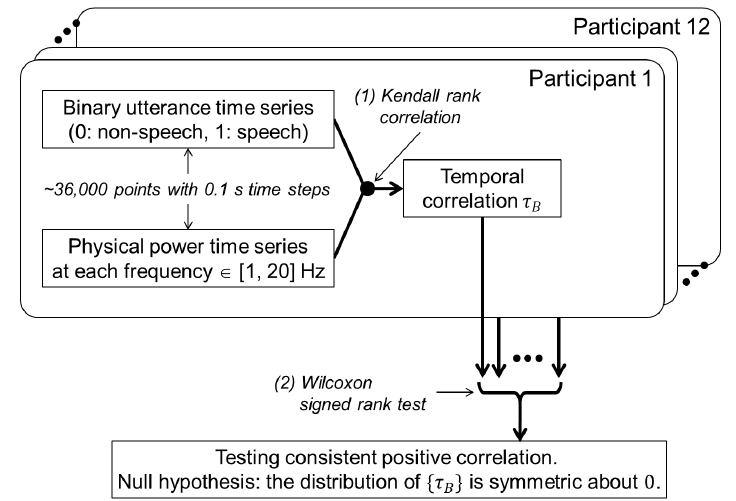
Figure 2. Analytic flow of the co-occurrence of utterances and physical motions.